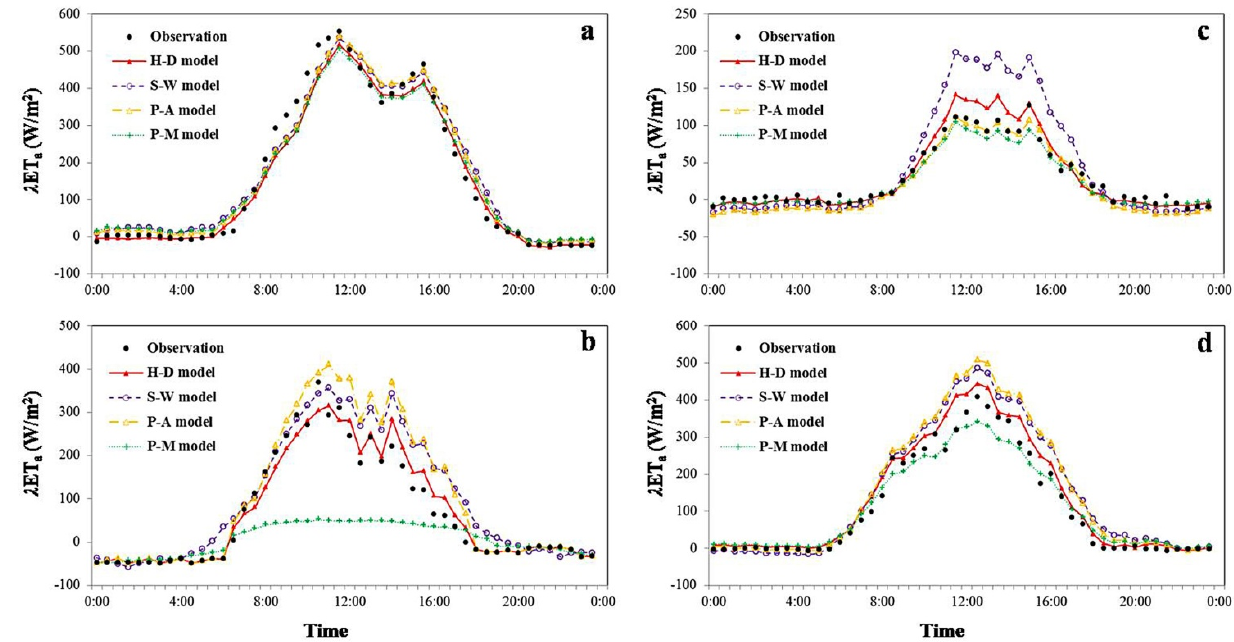
Figure 4. Diurnal patterns of the estimated actual evapotranspiration from the four models and the measurements at ( a ) US_MMS; ( b ) US_Fmf; ( c ) US_Var; ( d ) US_Bo1. Each time series shown is the mean of three typical clear-sky